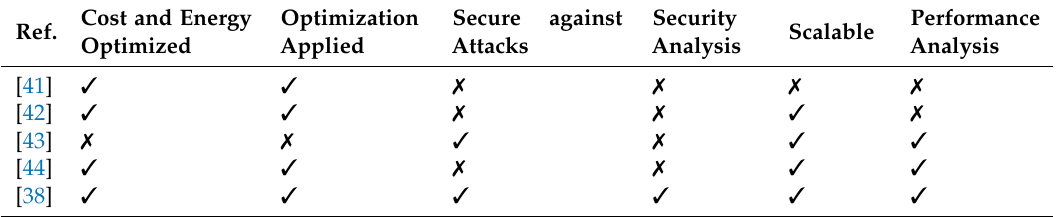
Table 2. Comparison of state-of-the-art research papers on P2P energy trading using blockchain.